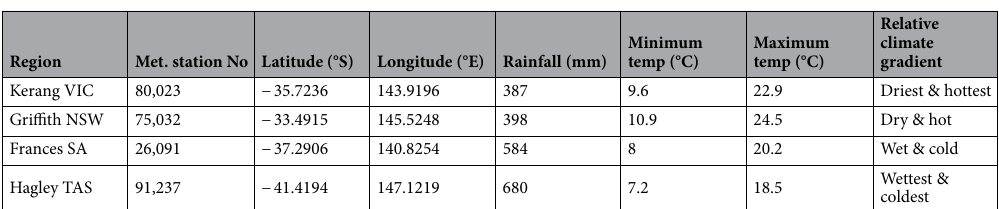
Table 1. Locations and long-term climate characteristics of sites used in this study.